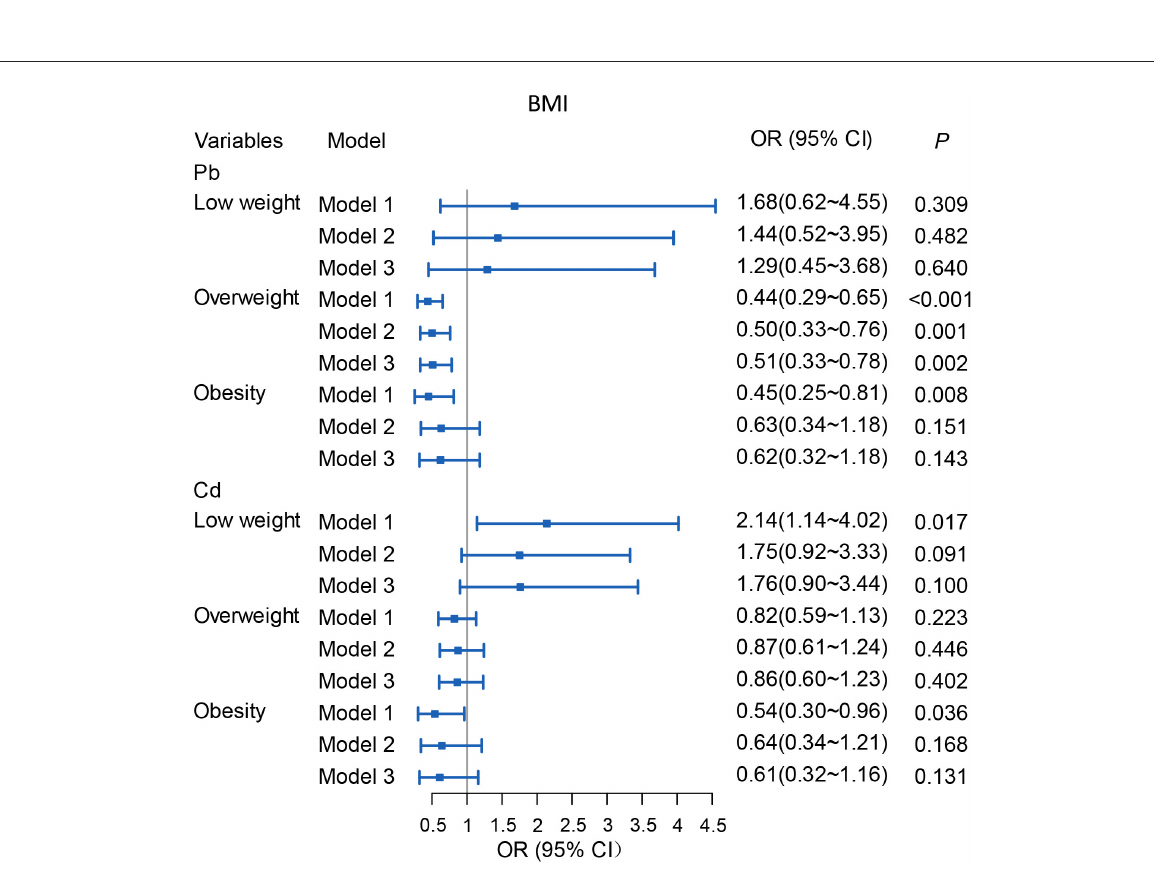
FIGURE5 Associations of ADDs [ µ g/(kg · d)] of Pb/Cd with BMI among total subjects. Model 1: The adjusted values for per capita monthly income, sex, age, education level and marital status. Model 2: The adjusted values for smoking, drinking, T2DM, hypertension, WHR, weekly exercise times, grade of BMI, and weekly intake of fresh vegetables/fruits; anxiety or depression state and stillness and sitting time. Model 3: The adjusted values for the covariates in Model 1 and Model 2. Reference level: Normal weight (18.5 ≤ BMI < 24). Pb, Total intake of Pb; Cd, Total intake of